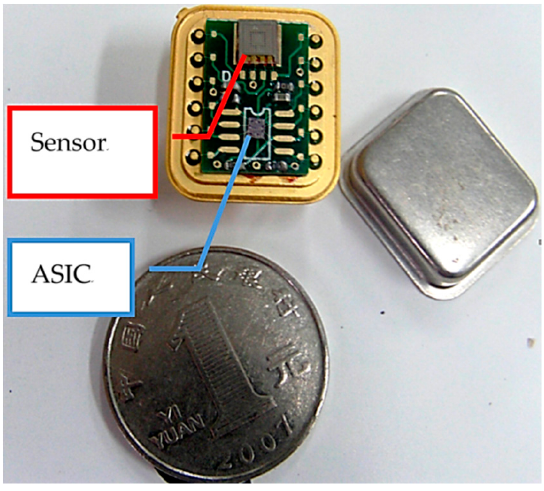
Figure 13. Photo of the hybrid integrated vacuum microelectronic accelerometer.